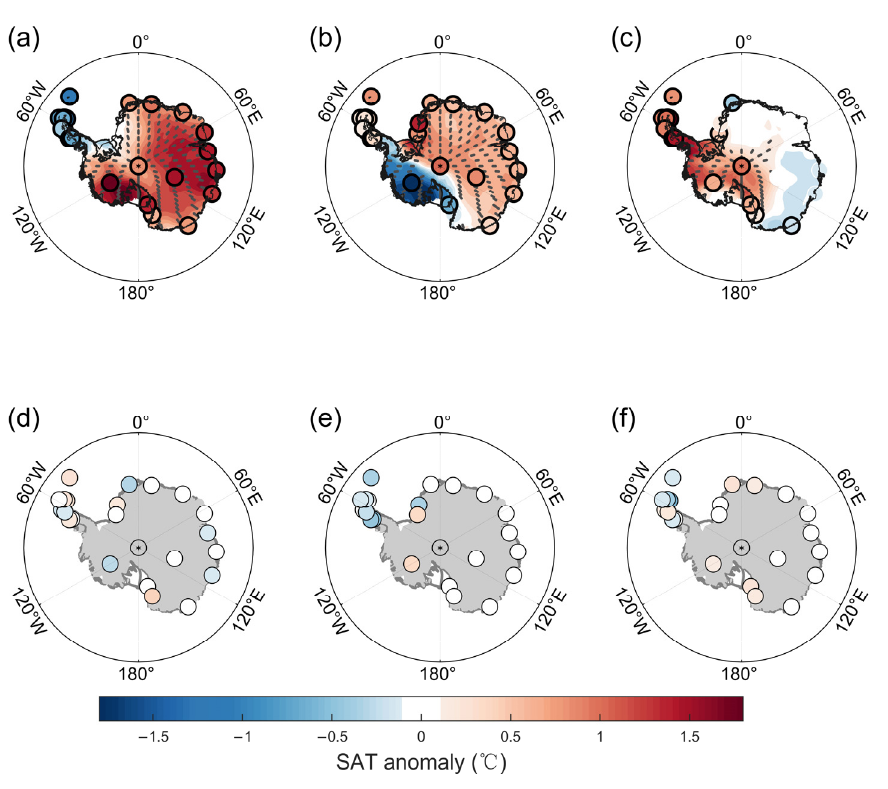
Figure 2. The first three modes of the combined maximum covariance analysis (CMCA) between station observations and reanalysis datasets for annual surface air temperature (SAT) anomalies over the Antarctic. ( a – c ) The spatial patterns of the ensemble mean of reanalysis datasets (color shading) and the station observations (color dots) for the CMCA Mode1 ( a ), Mode2 ( b ) and Mode3 ( c ). The scatter and black dots indicate points at which the spatial patterns are statistically significant at p < 0.05. ( d – f ) The differences in spatial pattern between the ensemble mean of reanalyses and station observations. The color bar is for ( a – f ).